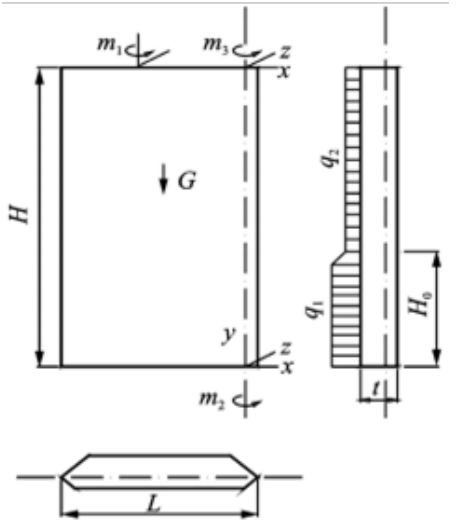
Figure 6. Schematic diagram of the force under the operation of the herringbone door.